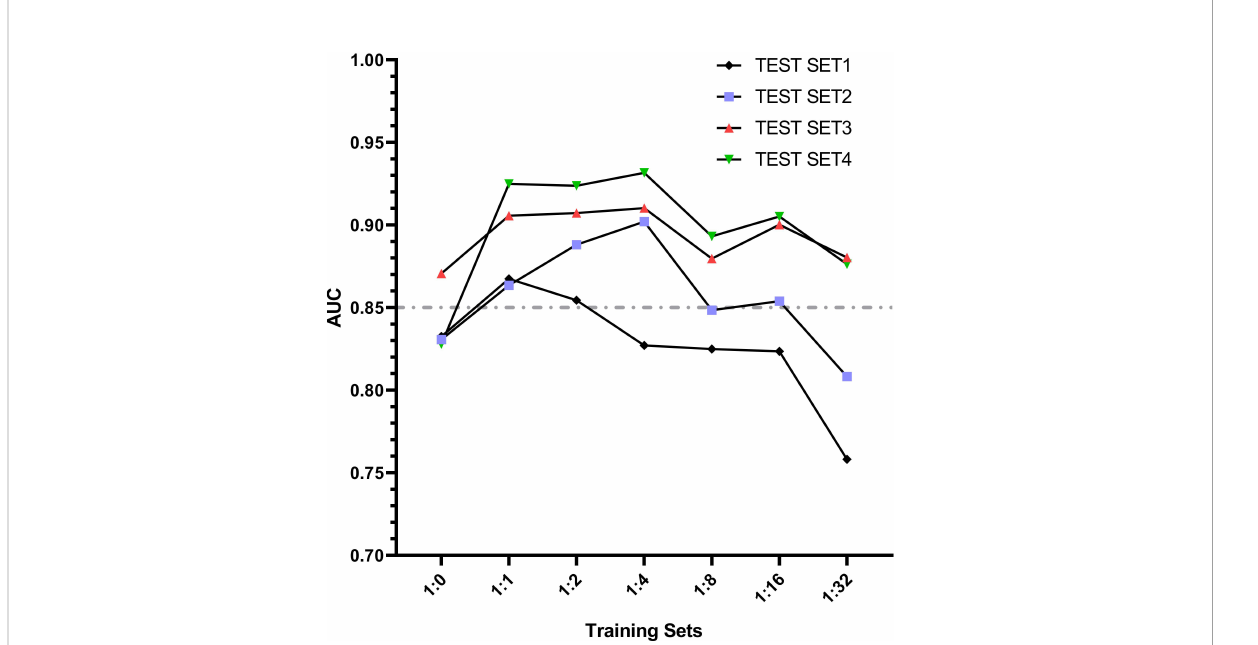
FIGURE 13 Curves of sensitivity, speci fi city, Youden index, and accuracy with threshold after test set 4 was tested separately by seven training set